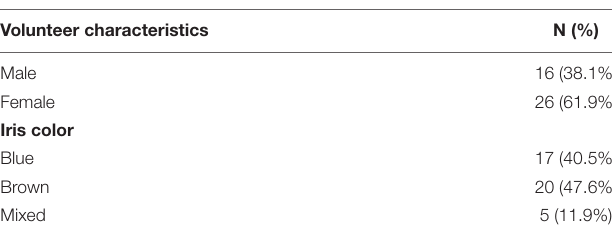
TABLE 1 | Characteristics of healthy volunteers for building sample PLR curves. Volunteer